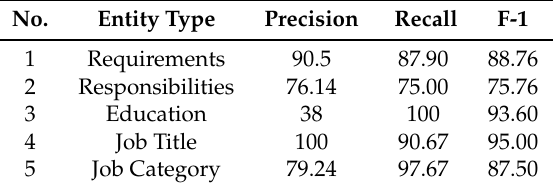
Table 11. Results of job description evaluation based on entity types in SAJ.